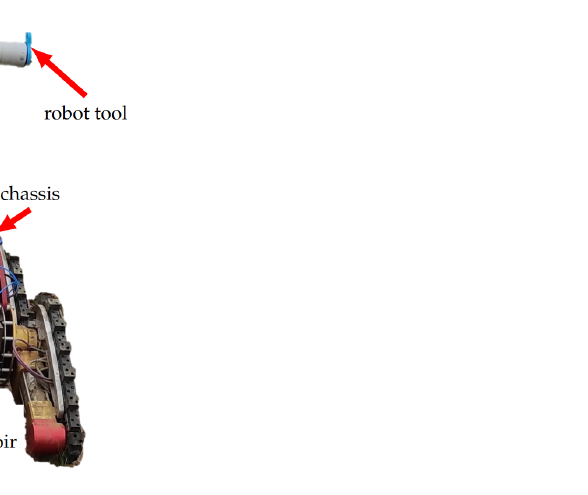
Figure 2. Design of an all-terrain mobile manipulator (ATMM) consisting of an all-terrain mobile robot (ATMR) driven by four independently controlled flippers/tracks and a 7 DoF robot